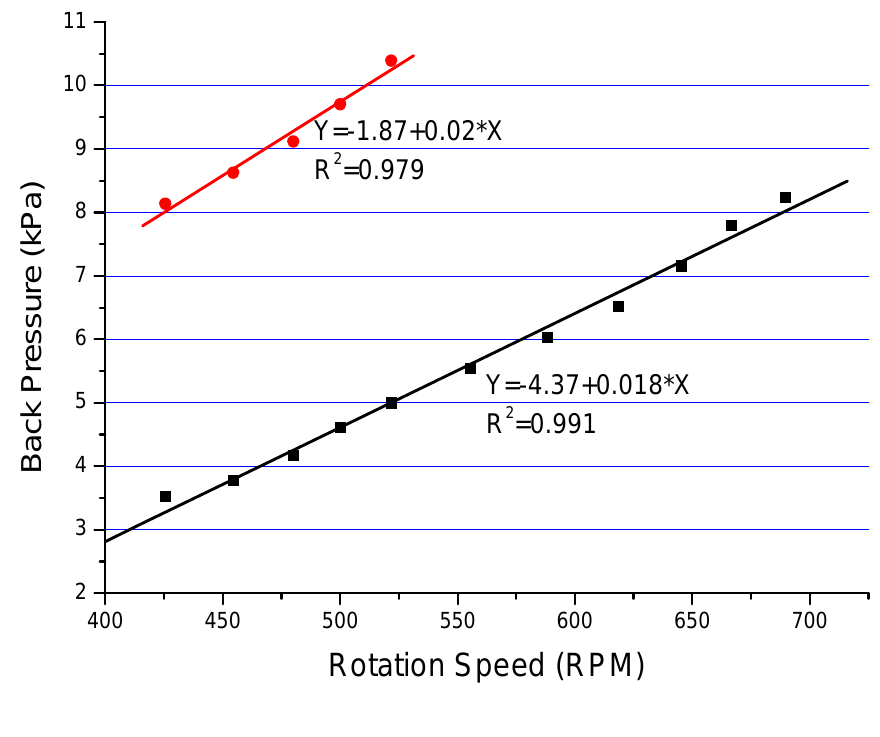
Figure 7. Back pressure vs rotation speed in high speed